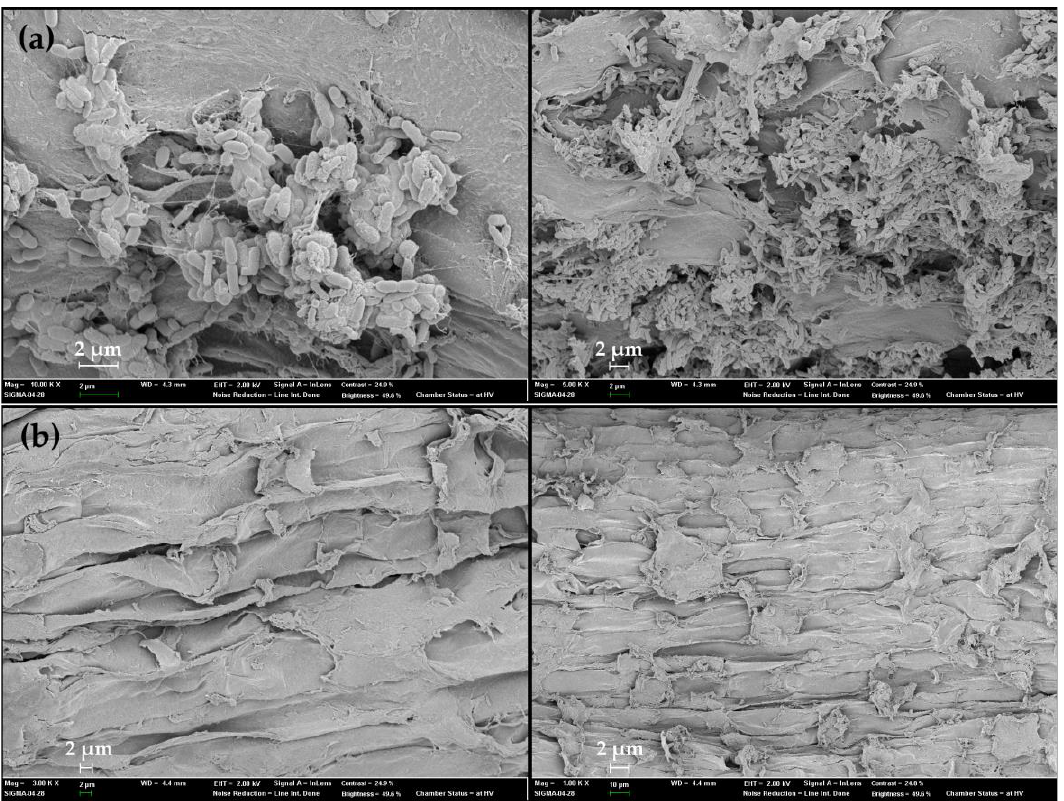
Figure 6. SEM images of rice plant root after 14 days of inoculation. ( a ) root colonized by Arthrobacter sp. GN70 and ( b ) control roots without inoculation. Bar 2 μm and 10 μm.